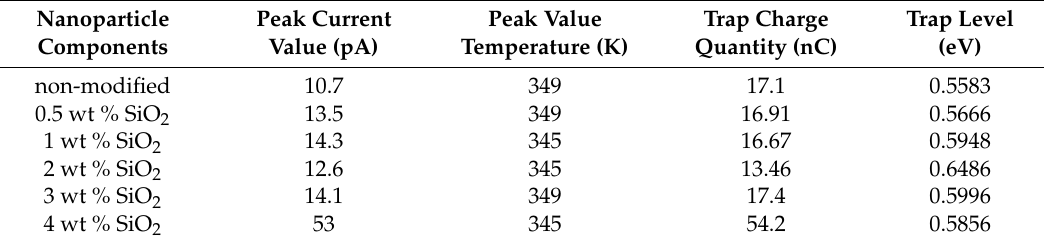
Table 1. Trap parameters of RIP with different nanoparticle